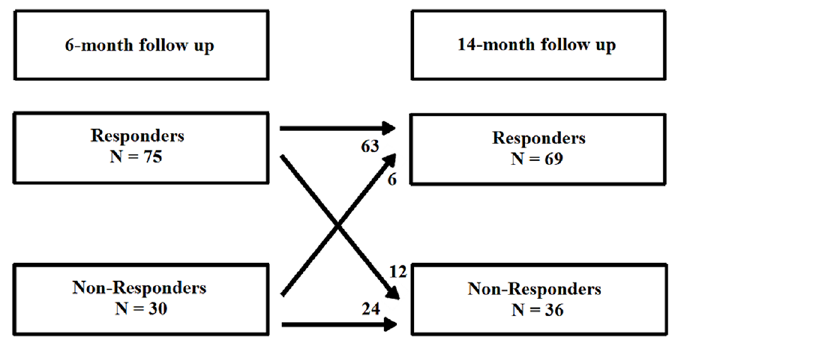
Fig 1. Flow chart of responders and non-responders.